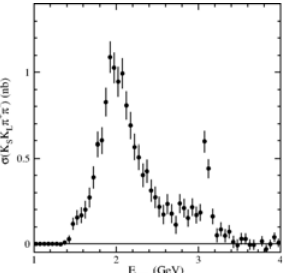
Figure 6. The e + e − → K 0 S K 0 L π + π − hadronic cross section at B A B AR . The peak at 3.1GeV is the J /ψ